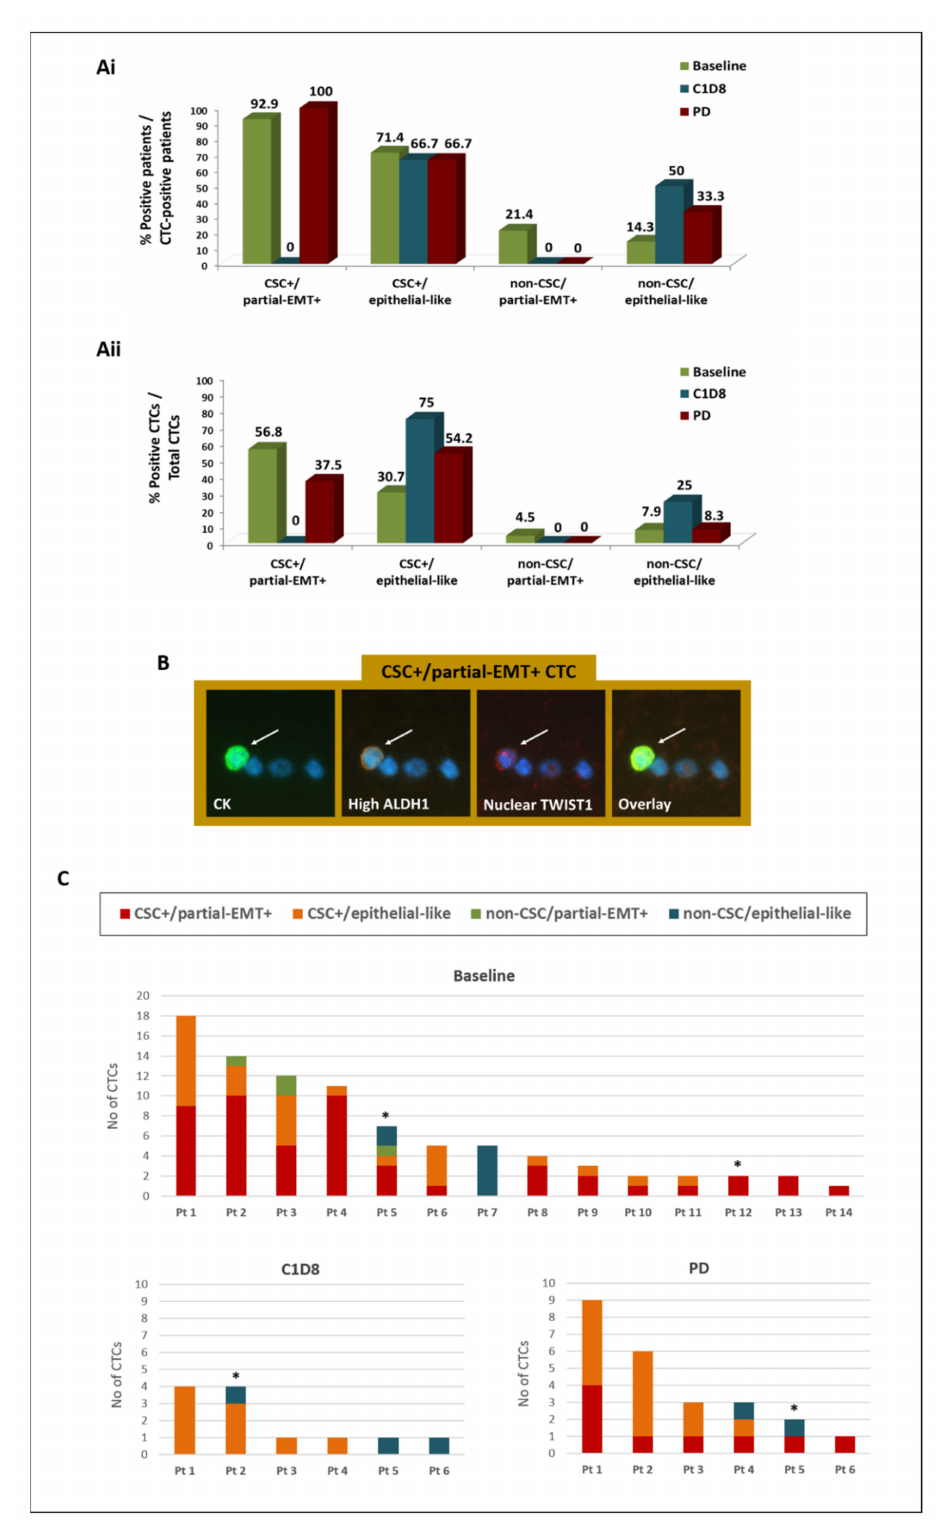
Figure 1. Distribution of the CSC-like and EMT-like phenotypes on CTCs of BC patients during eribulin treatment and on disease progression. ( Ai ) Percentage of patients harboring distinct CTC subsets; ( Aii ) Percentage of distinct CTC subsets per total CTCs; ( B ) Representative image of a CSC+/partial-EMT+ CTC (CK-positive cell—arrow) among PBMCs (CK-negative cells) detected in the peripheral blood of a BC patient: CKs (green), ALDH1 (orange), TWIST1 (red) and DAPI